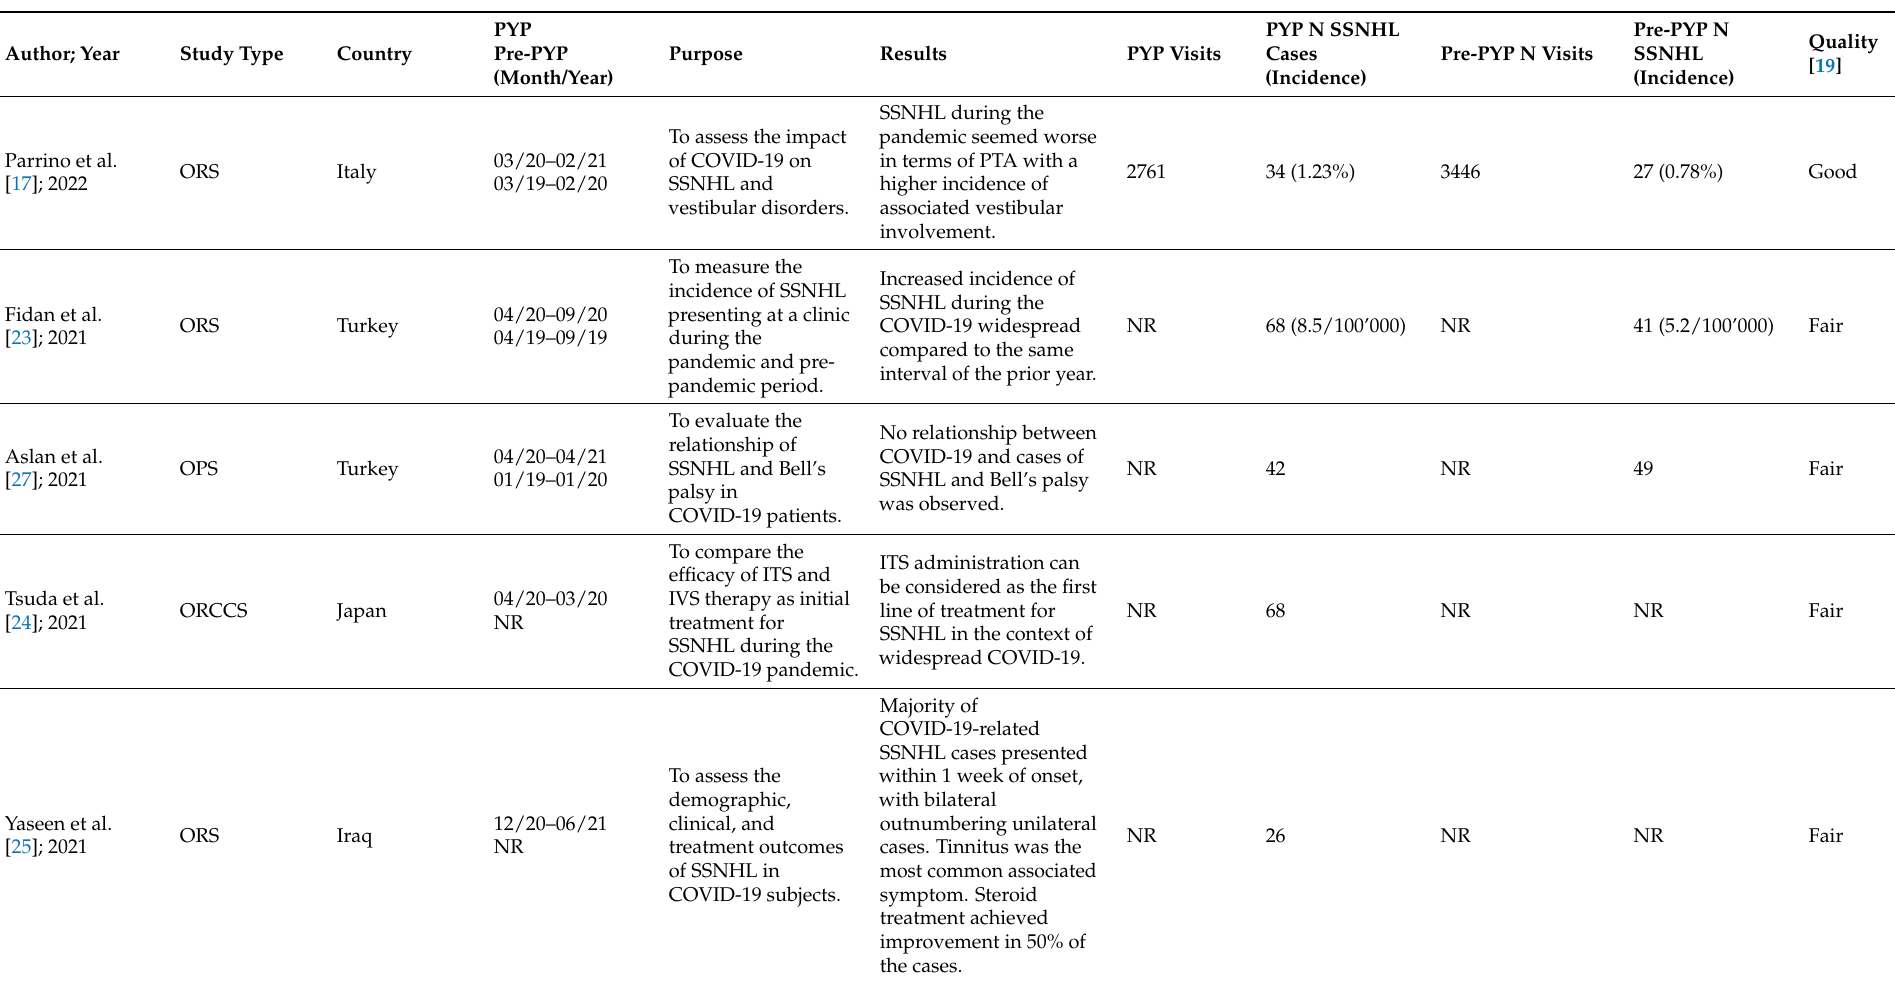
Table 1. Studies included in the review and their quality according to the National Institutes of Health Quality Assessment Tool for Observational Cohorts and Cross-Sectional Studies